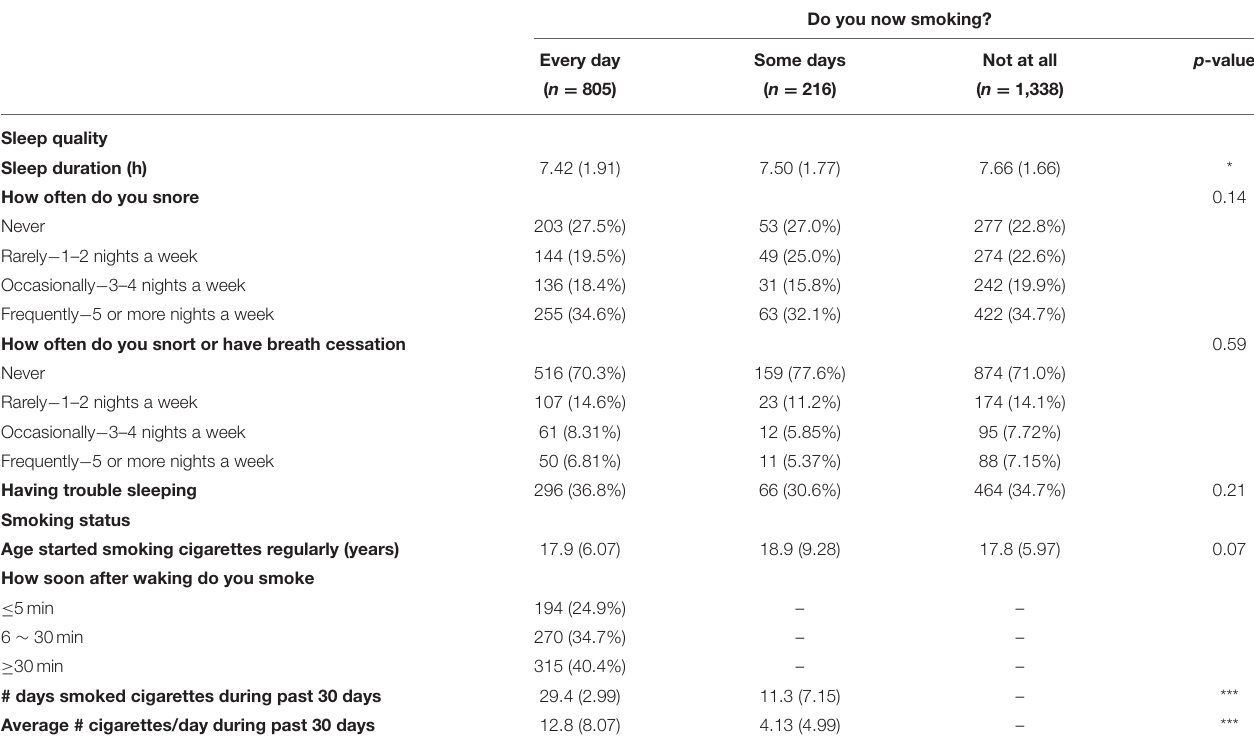
TABLE 5 | Sleep and smoking characteristics of study population grouped by smoking.